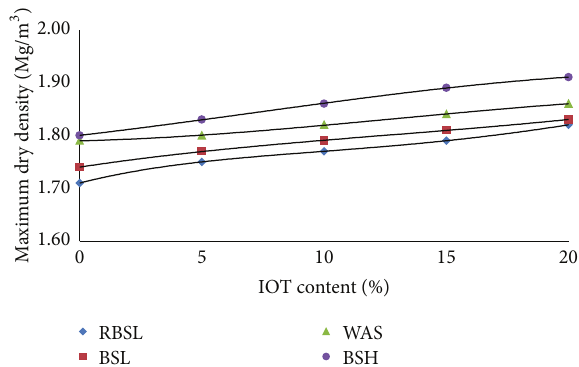
Figure 2: Maximum dry density versus iron ore tailings content